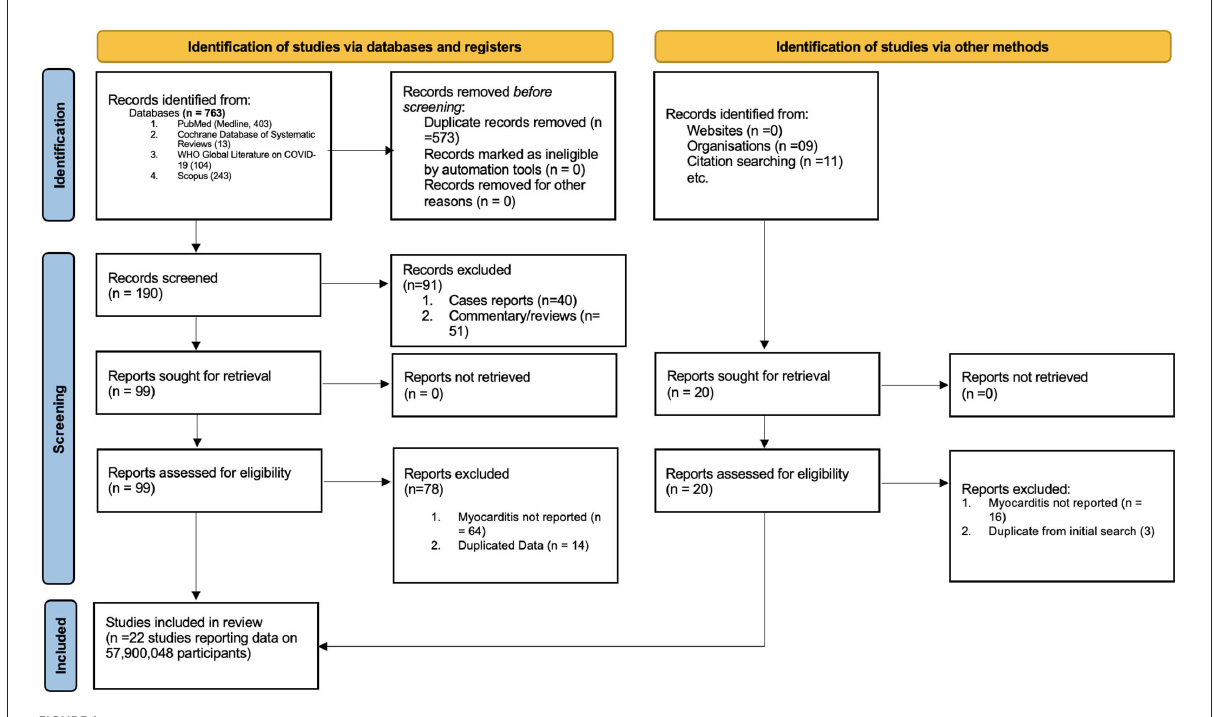
FIGURE1 PRISMA flow diagram for study